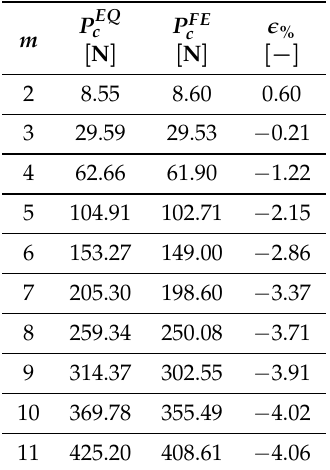
Figure 5. Non-dimensional critical load µ vs. the number of cells n , for the case study II and for different boundary conditions: ( a ) H-R; ( b ) C-F; ( c ) C-R; ( d ) C-S. Green curve (A): Timoshenko model; blue curve (B): FE solution; yellow (C) and red (D) curves: Timoshenko and Euler–Bernoulli models without constitutive geometric effect. Table 3. Critical loads of a sample H-R grid beam with n = 50, for different values of m